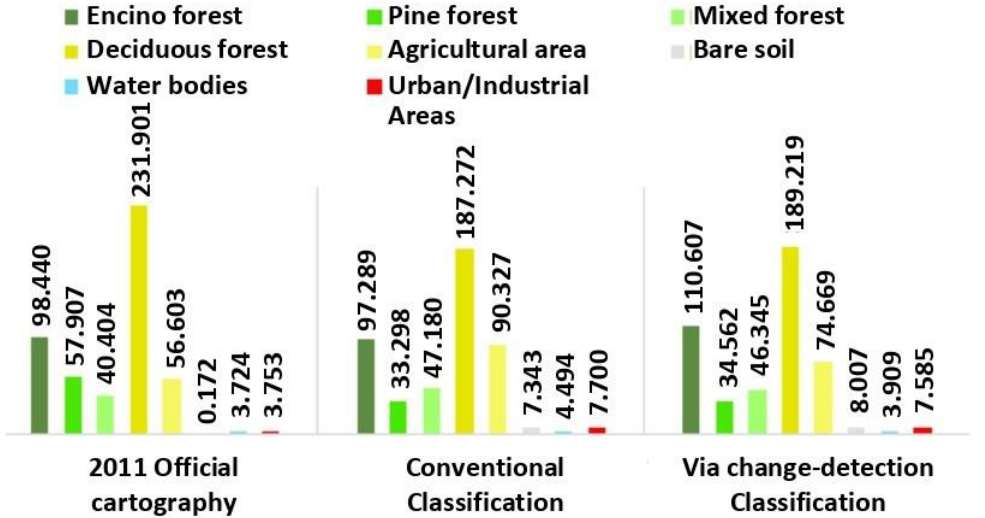
Figure 12. LULC surfaces of the generated maps by conventional methods and through change detection for the test date and the cartography LULC surfaces of 2011. Total surface: 474.904 hectares. Values in thousands of hectares.